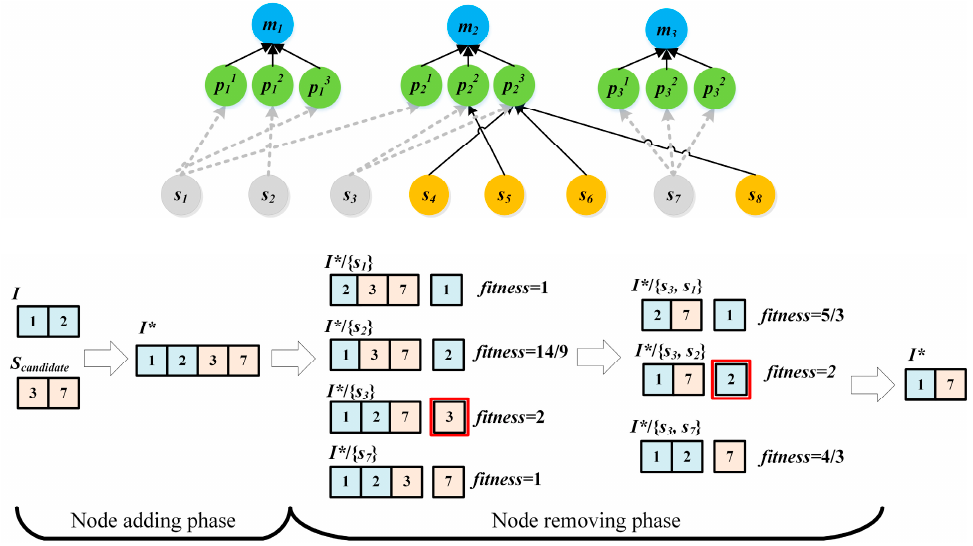
Figure 7. Exchanging-based search.